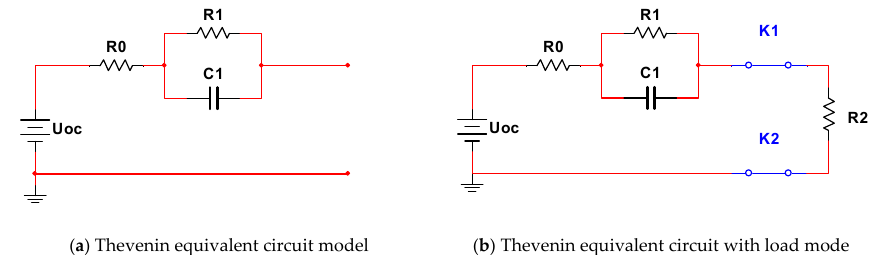
Figure 1. Thevenin equivalent circuit and load